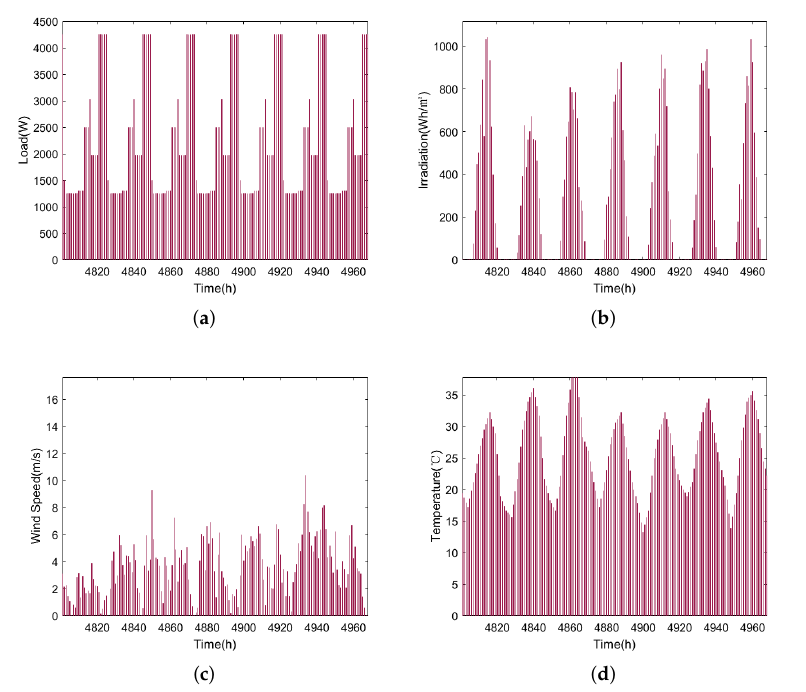
Figure 7. Typical week of peak power consumption. ( a ) Load. ( b ) Solar irradiation. ( c ) Temperature. ( d ) Wind